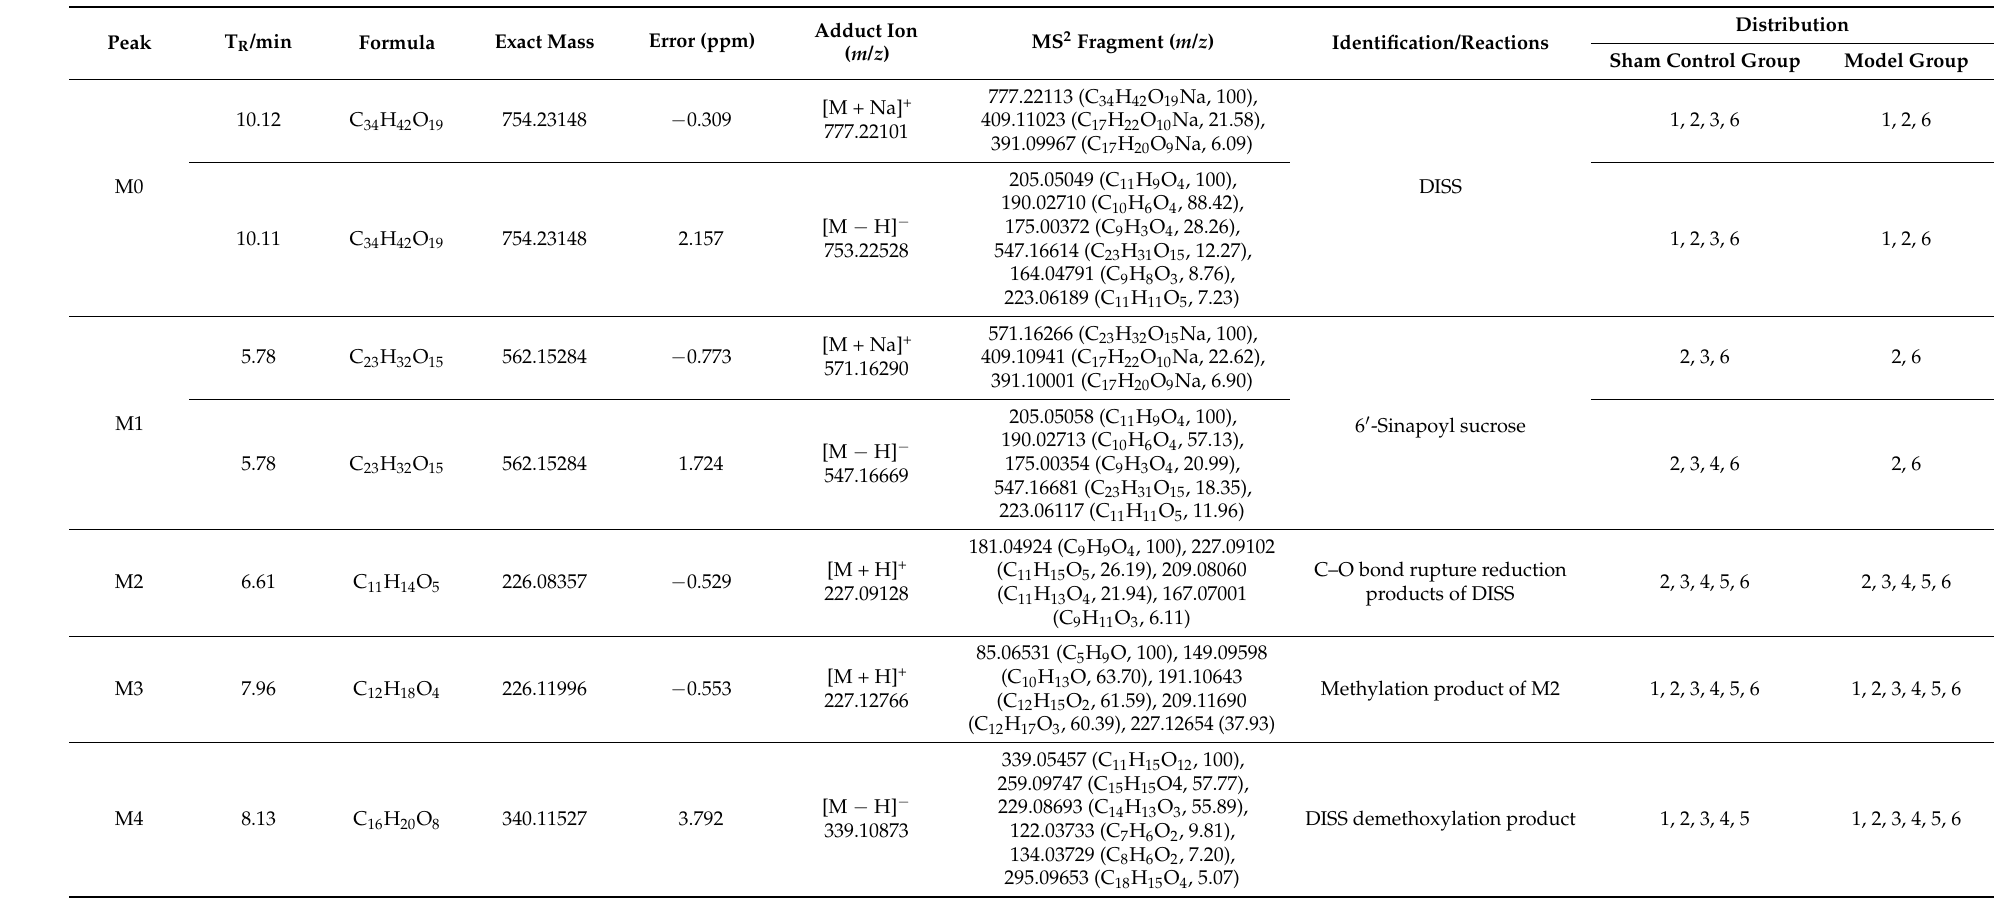
Table 1. Summary of DISS metabolites by